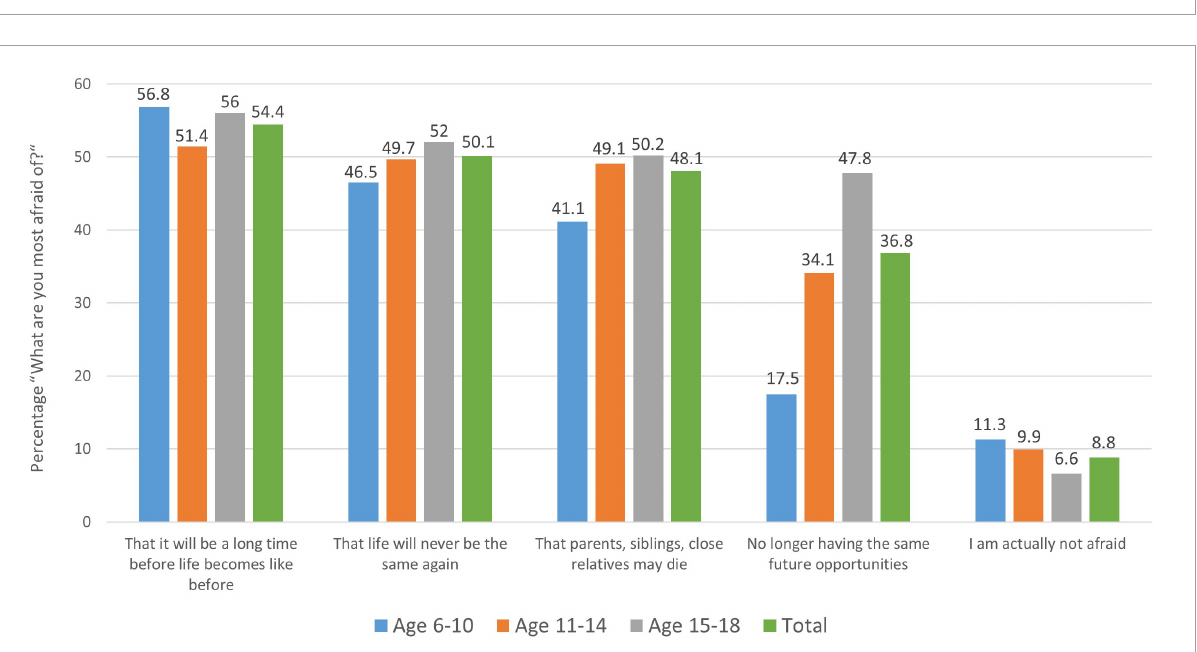
FIGURE1 Distribution of children’s and adolescents’ answers to the question “Does the current situation regarding the coronavirus scare you?” by age group and gender. Boys to the left, girls to the right with each age group (6–10 years, 11–14 years, and 15–18 years), and the total grand mean to the right. Each age category sums up to 100% (rounded values). Figures are modified and reproduced (CC BY 4.0) from Schabus and Eigl (2021).